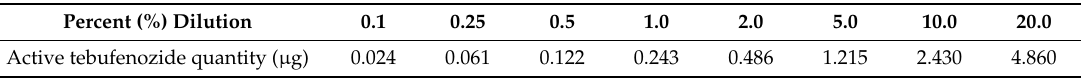
Table 1. Quantities of active tebufenozide ingredient diluted from RH-5992 flowable formulation Mimic ™ -2F [24.3 µ g / µ L], Rohm and Haas C., Spring House PA in used in 1 µ L topical applications on C. fumiferana